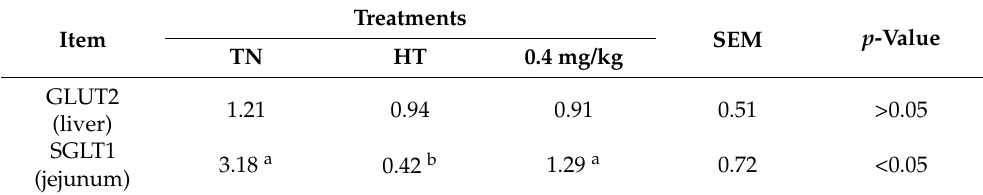
Table 8. Effects of chromium picolinate supplementation on the level of glucose transporter